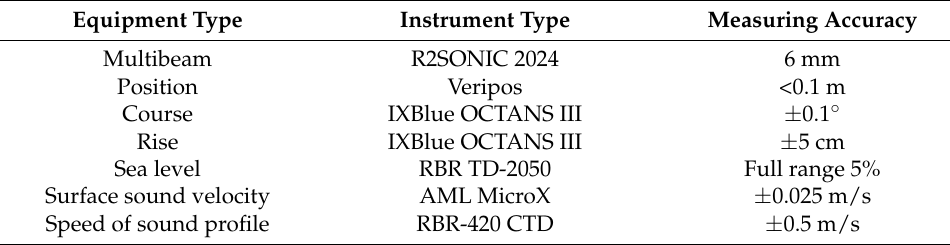
Figure 3. Schematic diagram of the Taiwan Banks location, where A is the panoramic position of SAR image data and B is the position of multibeam survey line data. Table 1. Multi-beam field survey equipment and accuracy.